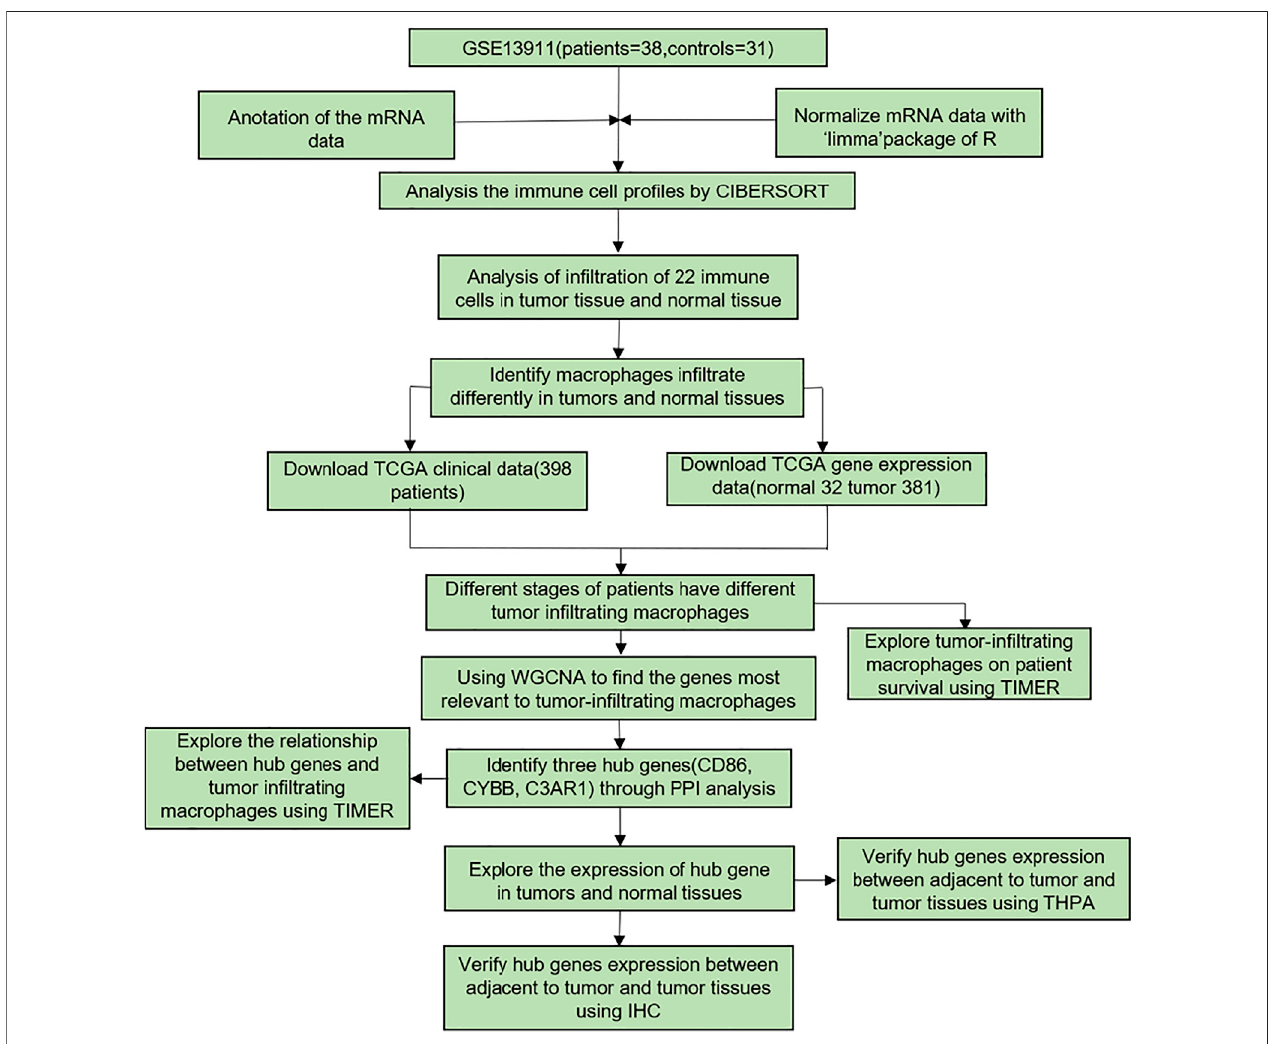
FIGURE1| The fl owchartofthedataprocessing.GSE13911wasusedtoanalyzetheimmunecellpro fi lesbyCIBERSORT.CorrespondingTCGAgeneexpression and clinical data were used to fi nd the genes related to tumor-in fi ltrating macrophages by WGCNA. Through PPI analysis, 3 hub genes were identi fi ed. The relationship betweenhubgenesandtumor-in fi ltratingmacrophageswasexploredbyTIMER.Theexpressionofhubgenesintumorandnormaltissueswasidenti fi edinGEPIA.HPA was utilized to verify the expression of hub genes between adjacent non-tumorous tumor and tumor tissues. This result was validated by IHC.